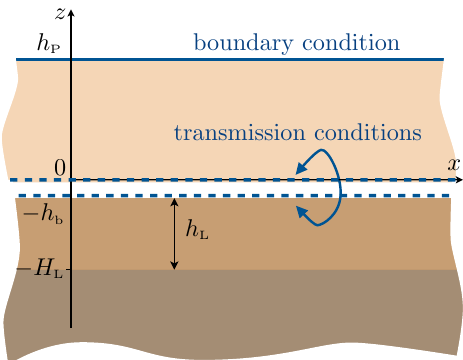
Figure 2. Configuration of the effective problem (2) and (3): The region of the plates has been replaced by a homogeneous medium; the effective boundary condition and transmission conditions encapsulate the effects of the heterogeneities at the decorative endings of the